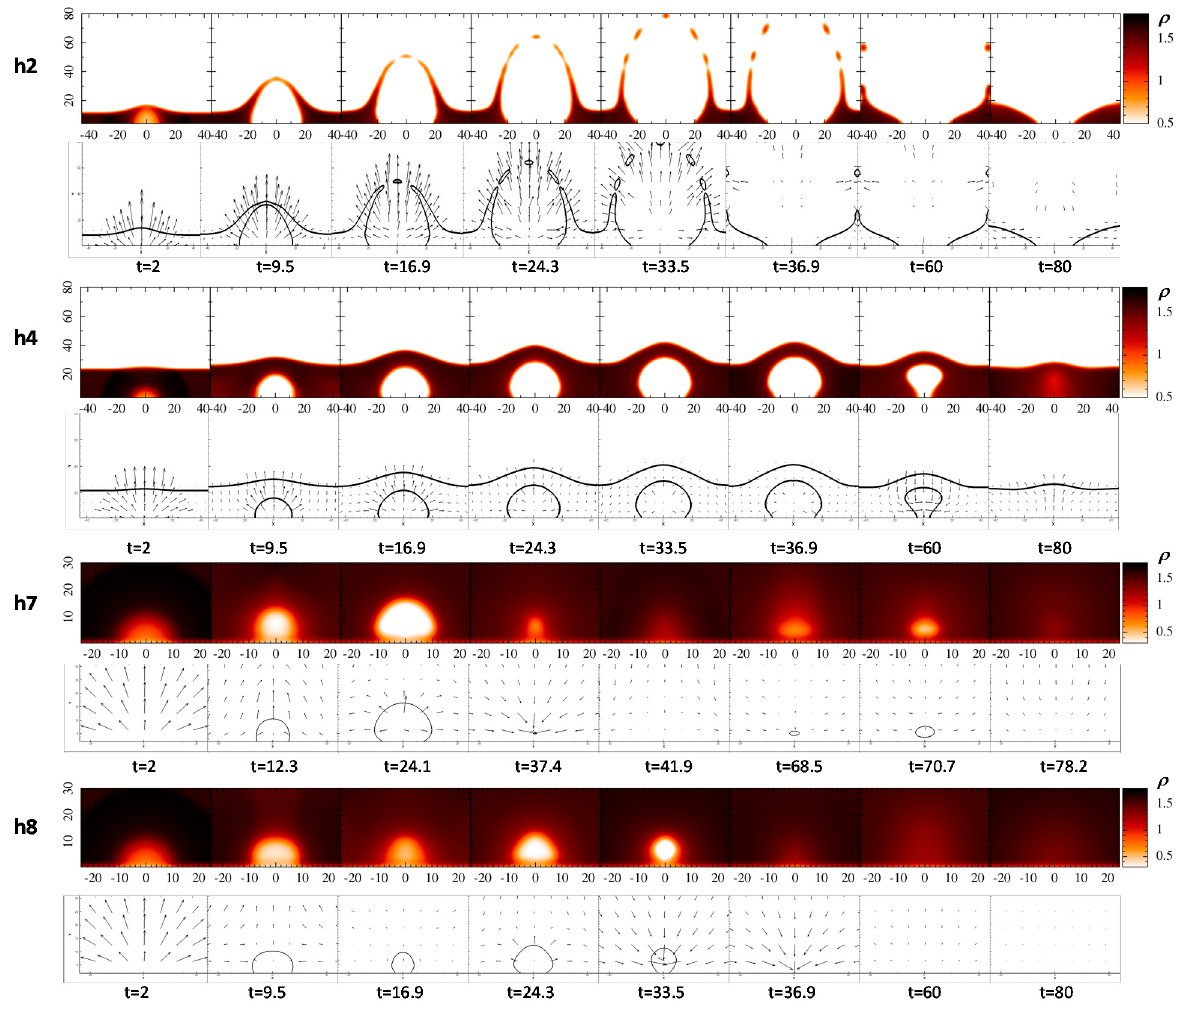
Water 2021 , 13 , x FOR PEER REVIEW 13 of 17 Figure 10. Bubble density counter (top) and flow field vector (below) for Cases h2, h4, h7, and h8. Figure 10. Bubble density counter ( top ) and flow field vector ( below ) for Cases h2, h4, h7, and h8.